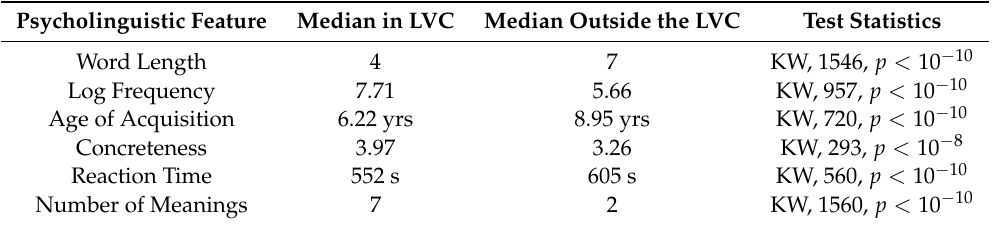
Table 1. Median psycholinguistic features of words within and outside the LVC and location equivalence test results (KW stands for Kruskal-Wallis). The LVC is richer in easier to parse/learn, concrete, shorter words than the rest of the multiplex